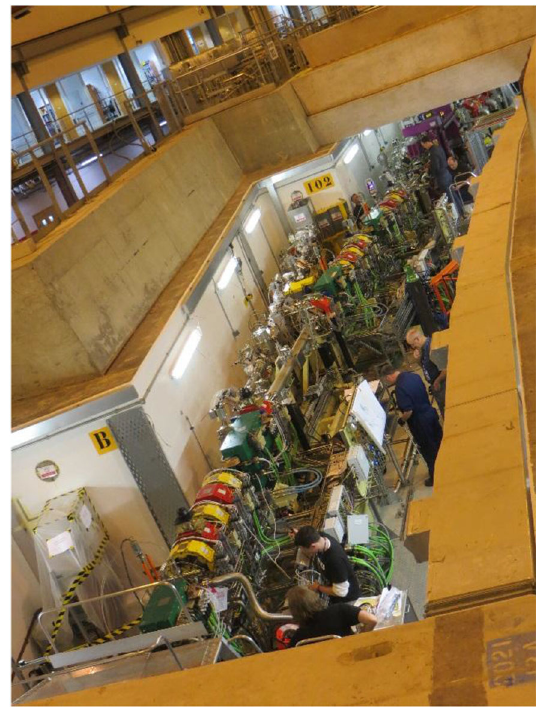
FIG. 11. 3D model of one of the DDBA girders [19]. FIG. 12. DDBA girders installed in the